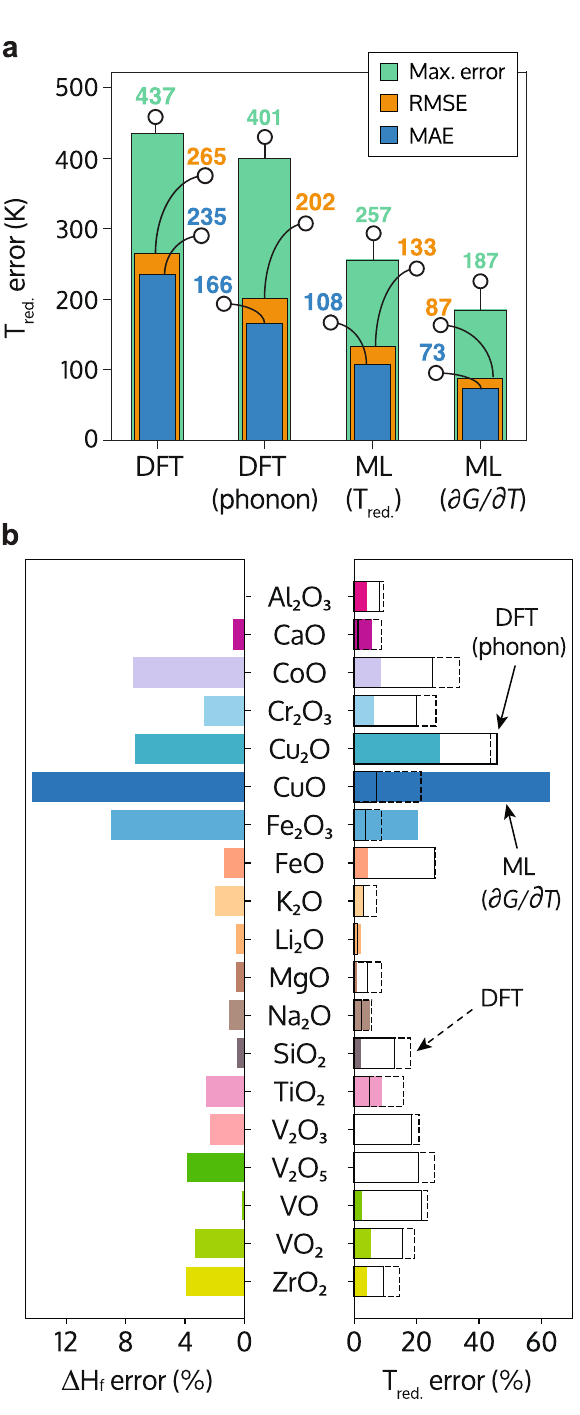
Fig. 4 Performance metrics for the DFT and ML theoretical models. a Mean absolute error (MAE, blue bars), root mean square error (RMSE, orange bars), and maximum error (green bars) of the theoretical models. b Comparison between the formation energy ( Δ H f ) and reduction temperature ( T red ) errors committed by the theoretical methods: density- functional theory (DFT, empty bars), DFT including phonon corrections (empty dashed bars) and the physics-based machine learning (ML) model trained for ∂ G / ∂ T (solid color